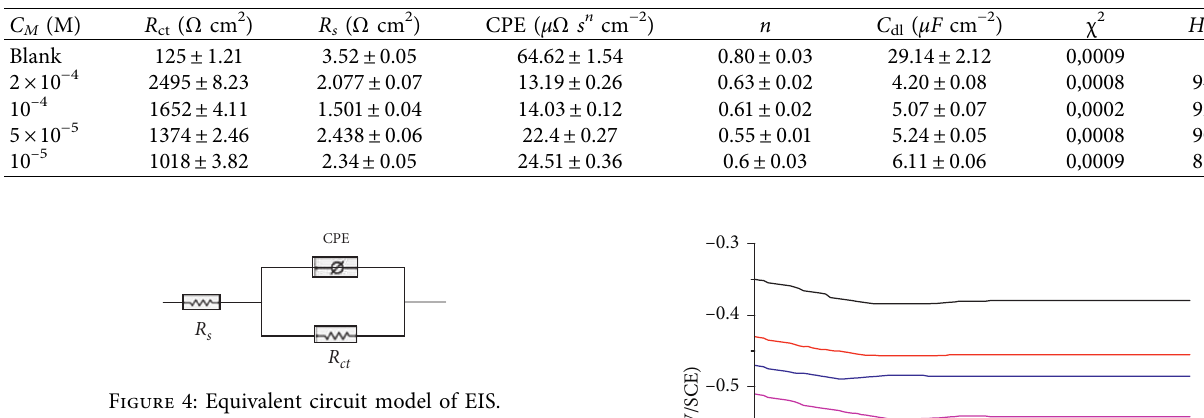
Figure 3: A representative of example simulation of (a) Nyquist and (b) Bode plots recorded for low carbon steel in 1.0M HCl without and with 2.10 − 4 M BPTU. Table 1: EIS parameters of low carbon steel in 1.0M HCl with different concentrations of BPTU.